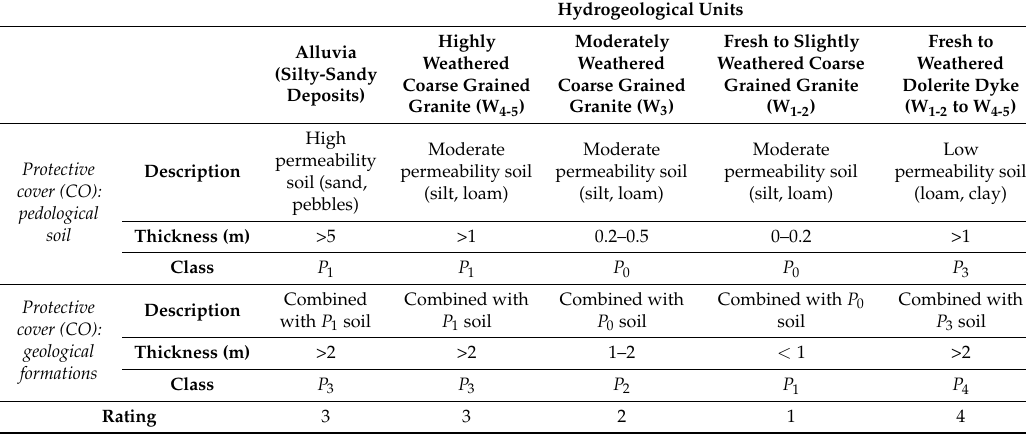
Figure 7. DISCO vulnerability index from Caldas da Cavaca aquifer systems: ( A ) discontinuities parameter for the hydromineral water wells; ( B ) protective cover parameter for the hydromineral water wells; ( C ) intermediate protection factor for the hydromineral water wells; ( D ) final protection factor for the hydromineral water wells. Table 2. Protective cover parameter evaluation taking into consideration geological formations and soils overlying aquifers in the Caldas da Cavaca site, adapted from [53].